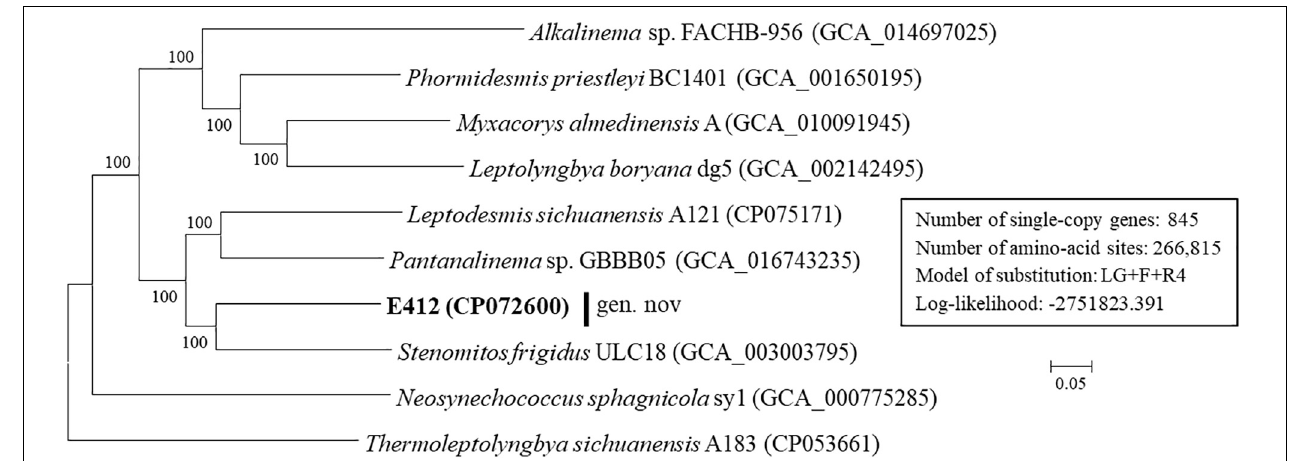
FIGURE 3 | ML phylogenomic tree of concatenated protein alignment of single-copy genes shared by all genomes. Strain no. in bold represent the strain identified in this study. Bootstrap values (1,000 replications) are indicated at nodes. Scale bar = 5% substitutions per site.